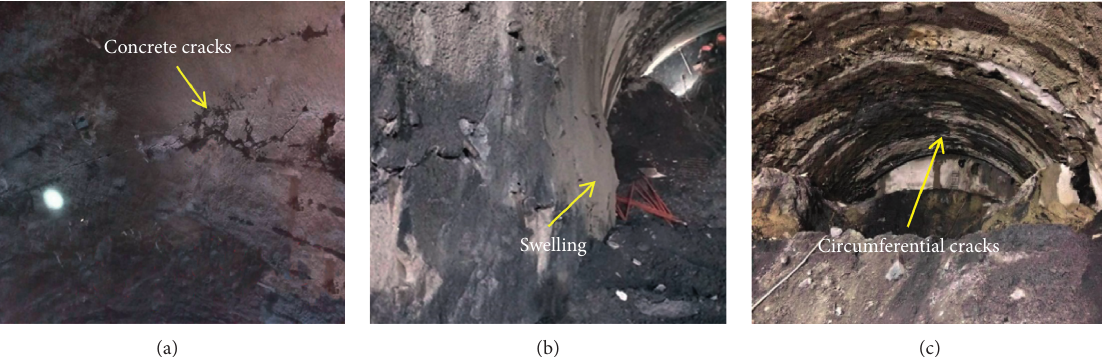
Figure 4: Tunnel deformations and destruction: (a) concrete cracks; (b) arch swelling; (c) circumferential cracks due to uneven longitudinal settlement.